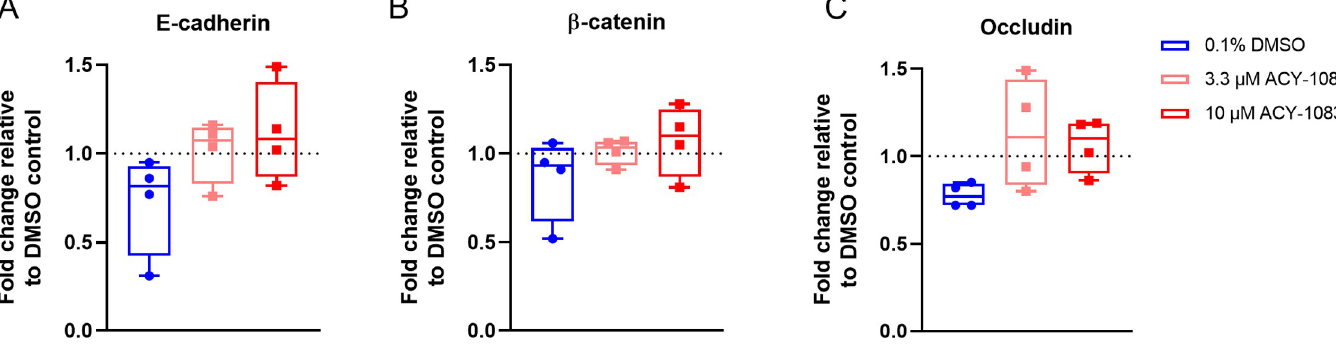
Fig 5. ACY-1083 does not increase tight-junction proteins in TNF-challenged HBEC ALI cultures. Western blot analysis of membrane proteins normalized to DMSO control without TNF (dotted line), (A) E-cadherin (B) β -catenin (C) Occludin. Box plot with dots representing 4 COPD donors and whiskers showing min and max. Statistical analysis was performed using one-way ANOVA with Dunnett’s multiple comparisons